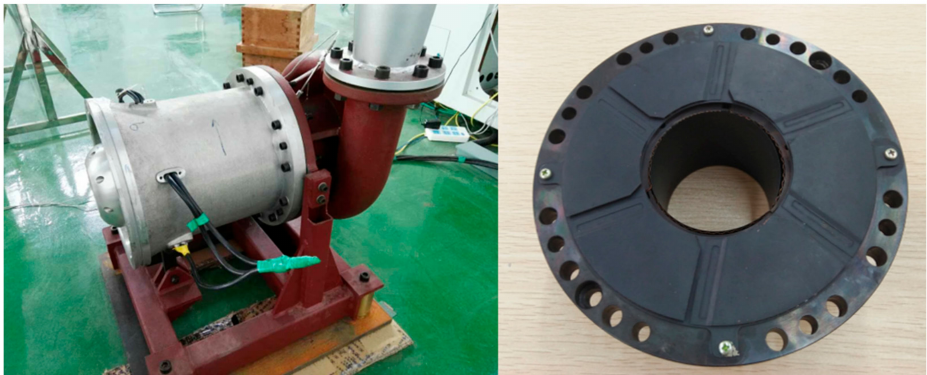
Figure 6. Centrifugal blower by the Institute of Machinery Manufacturing Technology, CAEP [53].